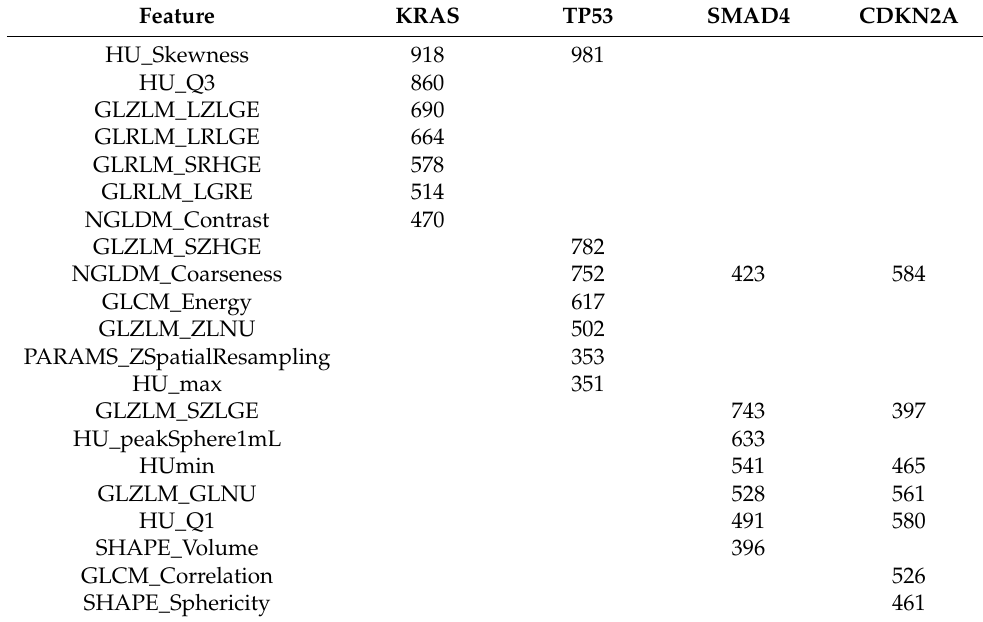
Table 3. Feature importance of method 1 for each gene mutation with a varying set of features. Feature importance was calculated as the number of cross-validation models a feature appeared in 1000 sets.